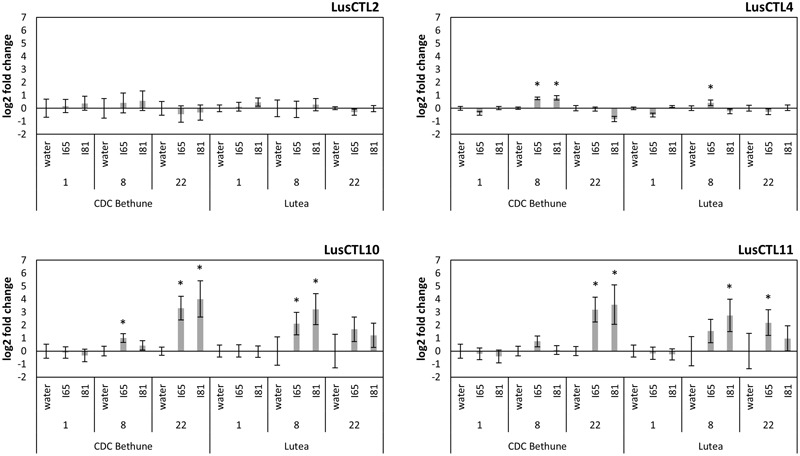
Log2-fold expression changes through a time course, of four chitinase genes in two flax cultivars (CDC Bethune and Lutea) upon Foln inoculation. Water: control plants, I65: fungal isolate #65 inoculated plants, I81: fungal isolate #81 inoculated plants. Numbers below each treatment indicate days post-inoculation. Error bars are the standard error of the ΔΔCt values (log2-fold changes) calculated as the square root of SEM2(Δcontrol) + SEM2(Δtreatment). Asterisks denote significant differences between the inoculation treatment and the respective water control (one-tailed t-test, p < 0.05). Names of chitinases correspond to those referenced in Mokshina et al. (2014).